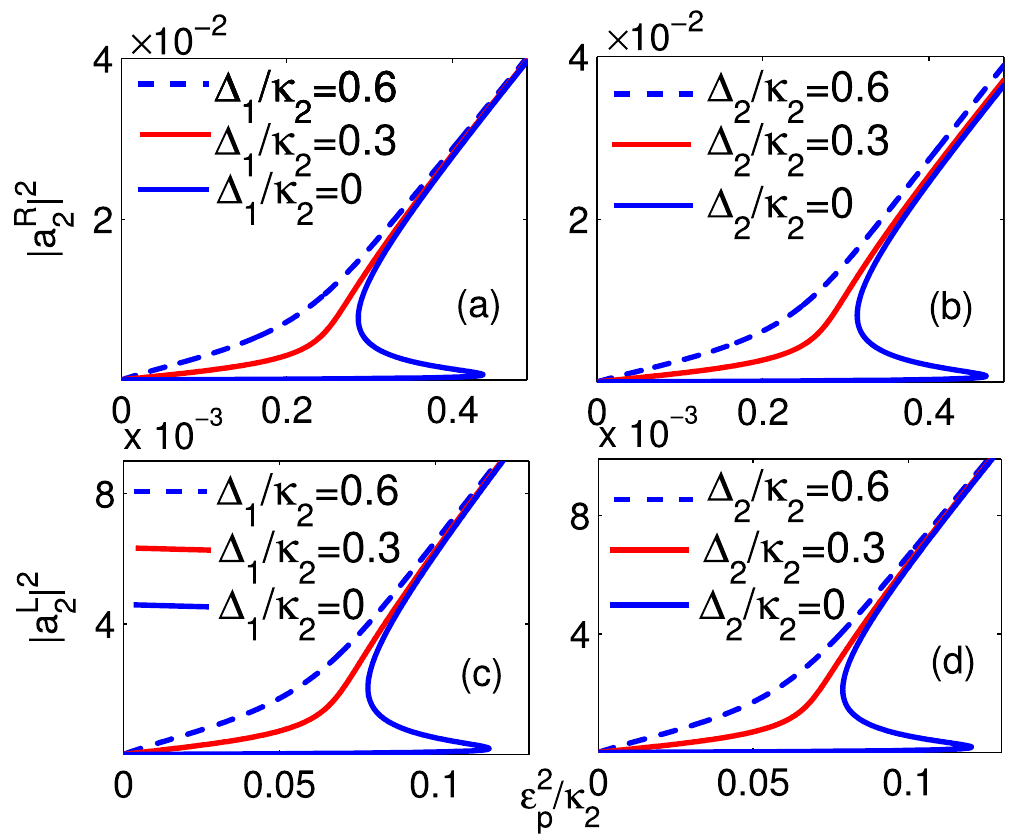
2 2 , ( b , d ) a L as a 2 1